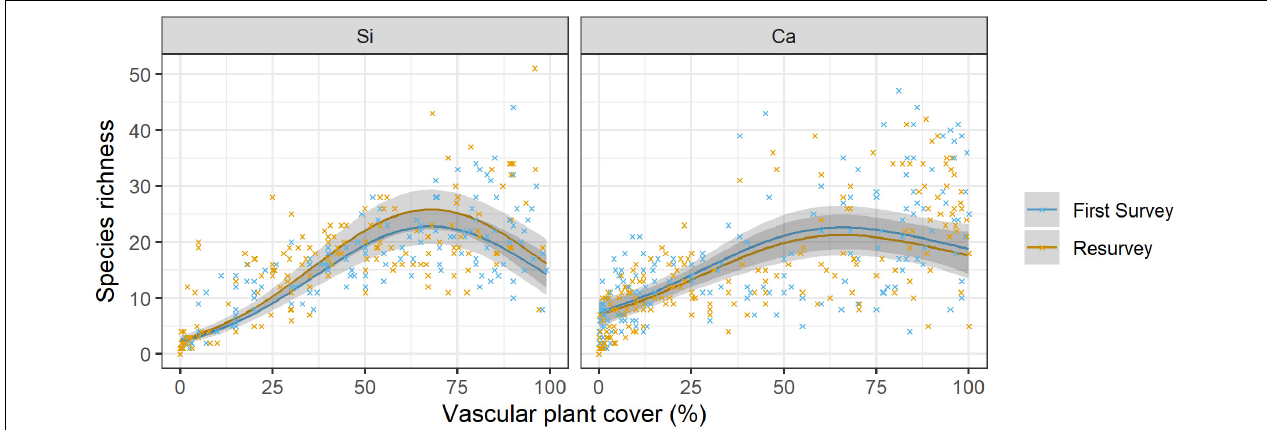
FIGURE 3 | Relationship of species richness with vascular plant cover per 1 m × 1 m plot over time (first survey vs resurvey) on siliceous and calcareous bedrock. The lines show the predicted mean species richness and the 95% confidence interval (in grey) from a negative binomial GLMM. Mean values and standard errors were calculated across aspects and random regions. Crosses represent data. Coefficients and significance levels of effects are given in Table 4 .